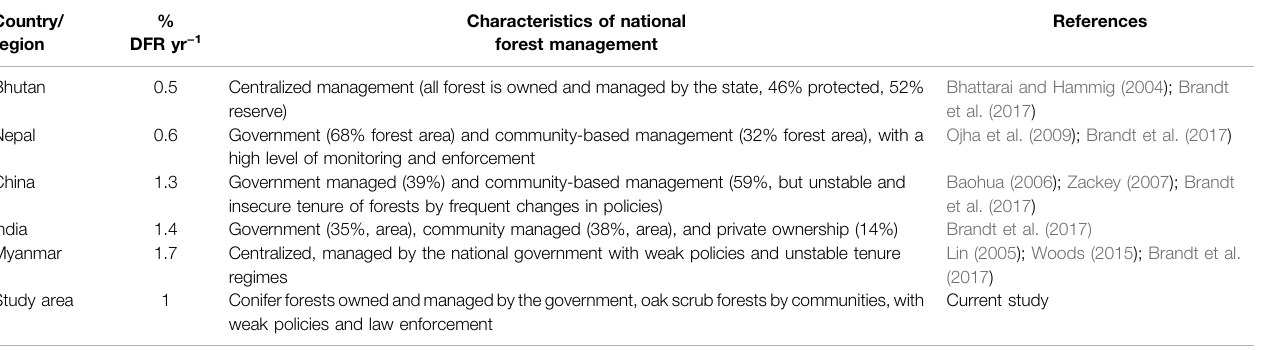
TABLE 3 | Characteristics of the national forest management regime and the rate of deforestation. Country/